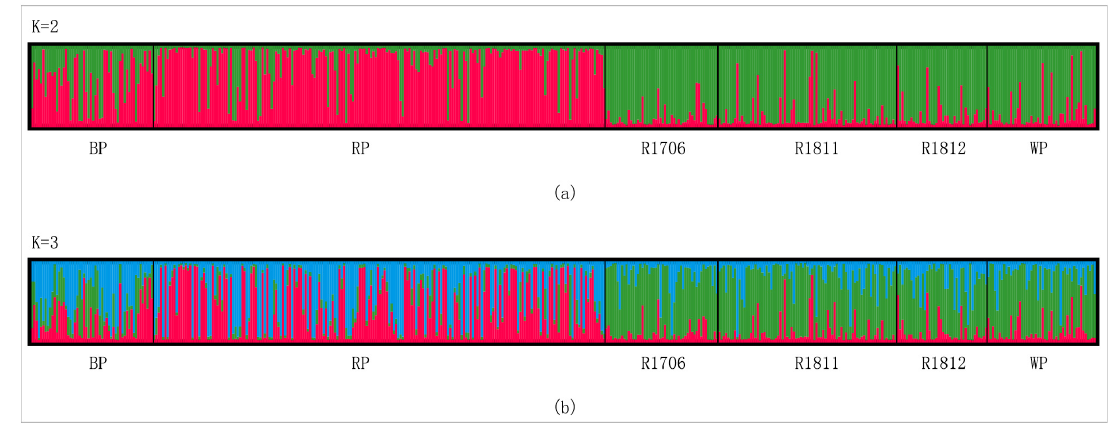
Figure 4. Results of structure analysis based on microsatellite loci. Each individual is represented by a vertical line, which is colored according to the assigned groups at estimated K = 2 ( a ) and K = 3 ( b ).